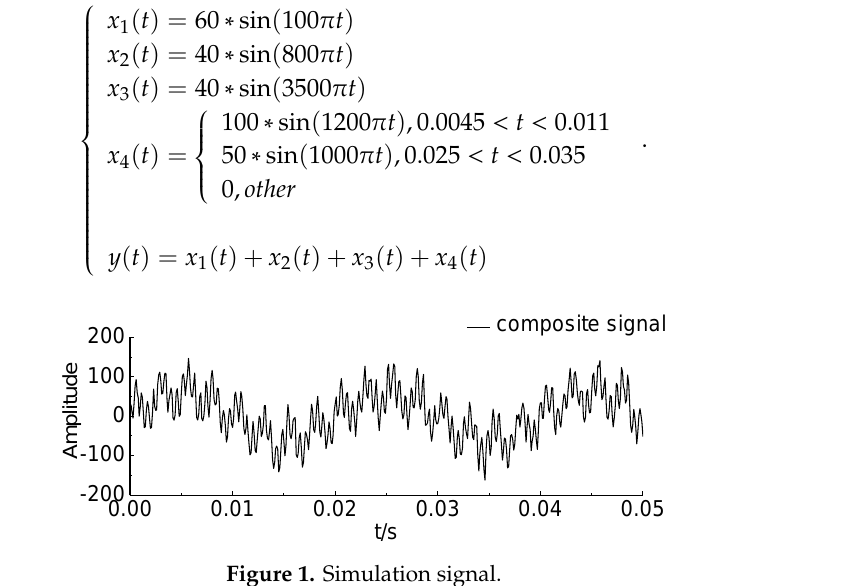
Figure 1. Simulation signal.